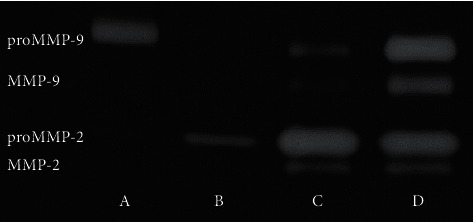
Representative zymogram of different materials from one patient. A–capillary blood standard; B–plasma; C–reference tissue; and D–plaque.